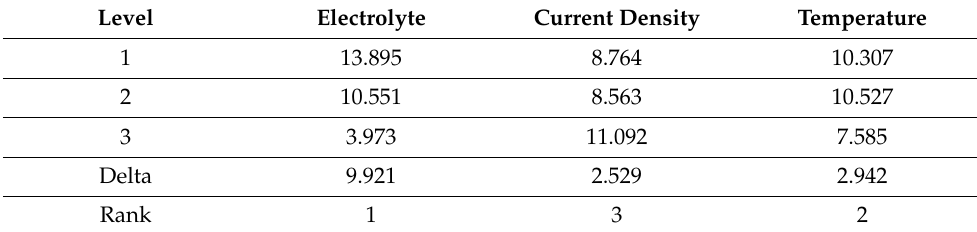
Figure 1. Pareto chart of the standardized effects of factors with signal-to-noise ratios. Table 6. Response table of roughness signal-to-noise ratio—smaller the